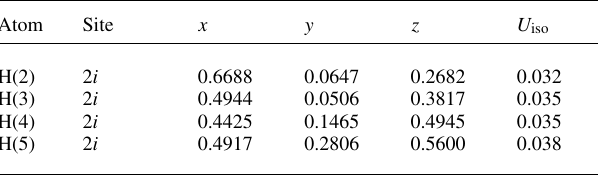
Table 2. Atomic coordinates and displacement parameters (in Å 2 )